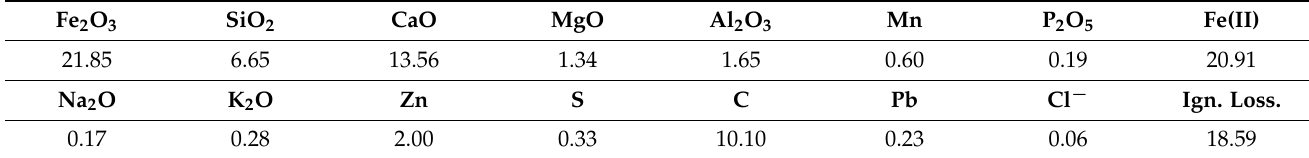
Table 1. Chemical composition of metallurgical sludge waste (%)